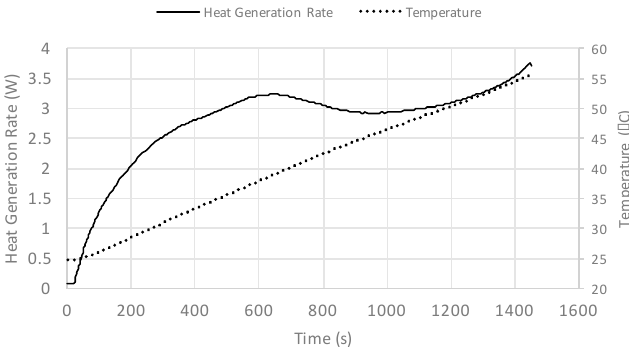
Figure 6. Heat generation rate and the corresponding temperature increase at 2C discharge rate.